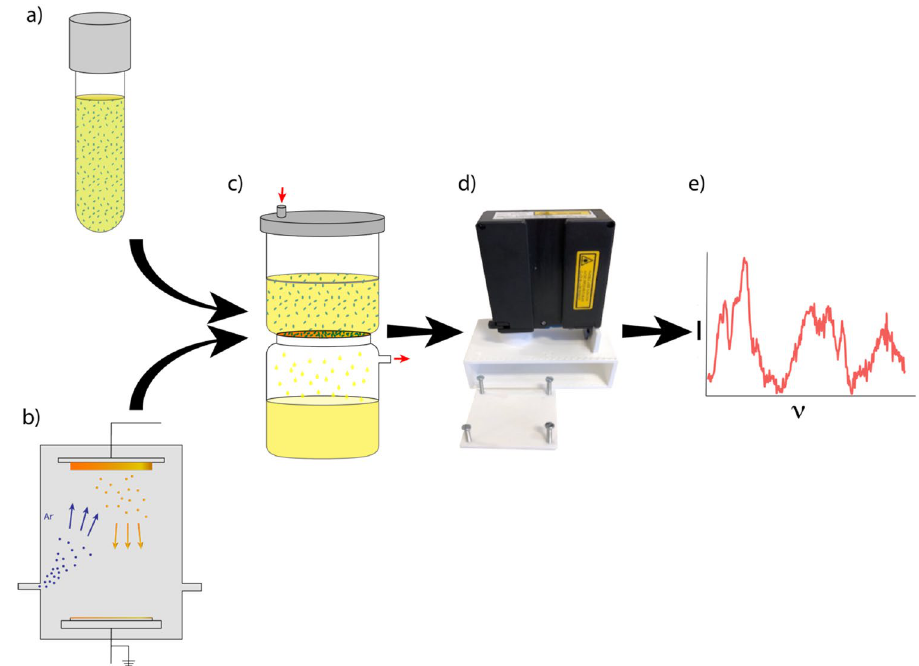
Figure 5. Methods overview. ( a ) Phantom urine samples were prepared by inoculating uropathogens (illustrated as blue ovals) into urine samples from healthy volunteers. ( b ) SERS-active filters were prepared by applying a 50 nm gold coating to polyvinylidene fluoride membrane filters using physical vapour deposition. ( c ) Vacuum filtration captured the uropathogens from urine and applied them directly to the SERS-enhancing surface (Red arrows indicate direction of vacuum). ( d ) Raman spectra were collected with a handheld spectrometer supported by a custom 3D-printed holder. ( e ) The spectra were plotted and analyzed (I—intensity,